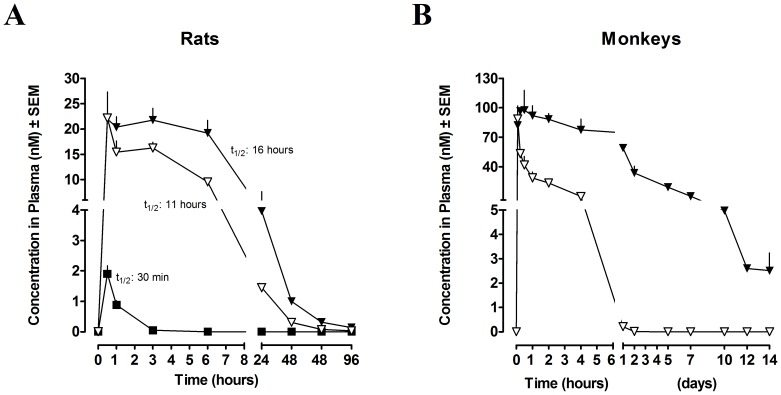
PK profile of intravenously dosed peptides in rats and monkeys.(A) rats, n = 3–4 and (B) monkeys, n = 3. Exenatide (▪), [Leu14]exenatide-ABD (▾) and [Leu14]exenatide-ABP (▿). Data are presented as mean ± SEM.